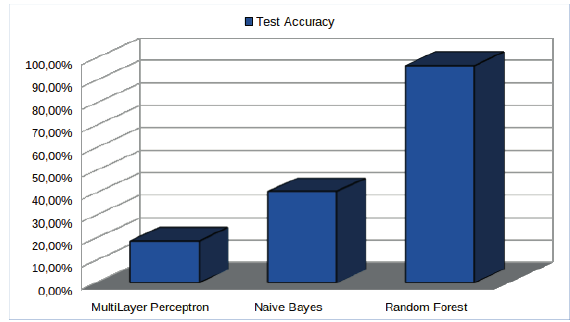
Figure 6. Test accuracy of the classifi ers.